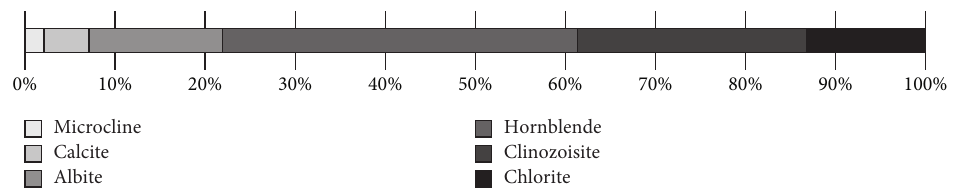
Figure 1: Bulk mineralogy of crushed rock aggregates. Table 1: Chemical composition of crushed rock aggregates (weight percent of major oxides).